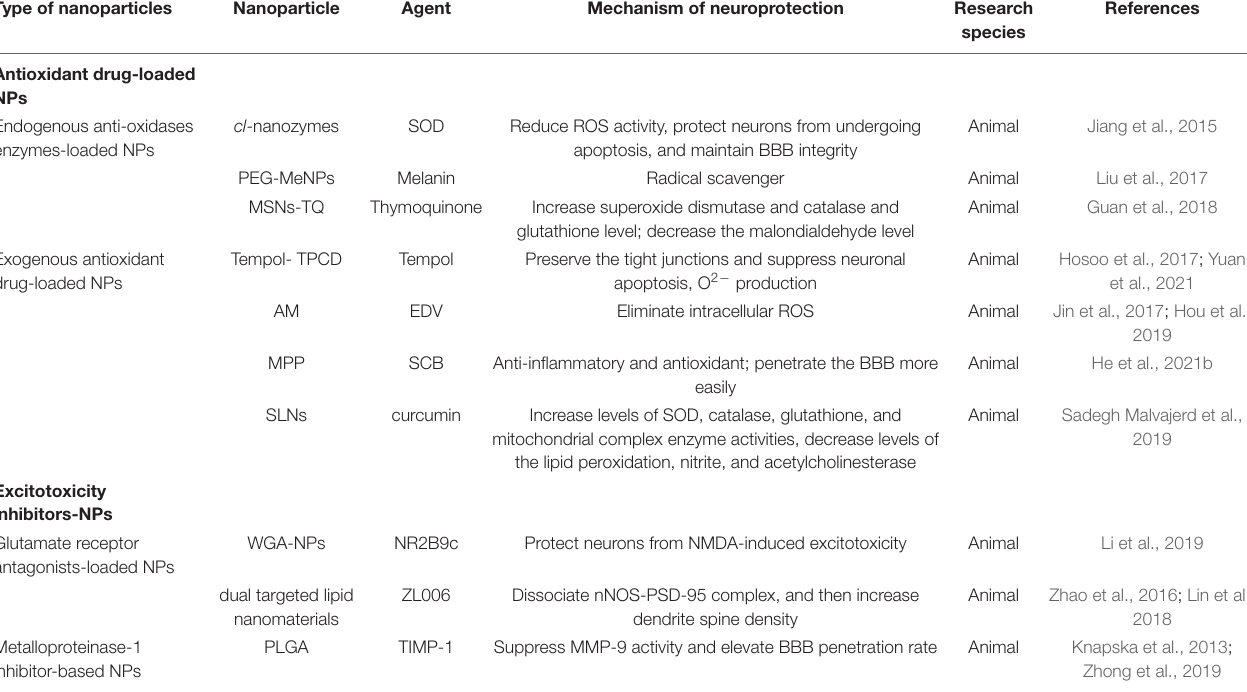
TABLE 2 | Summary of antioxidant drug-loaded nanoparticles and excitotoxicity inhibitors-loaded